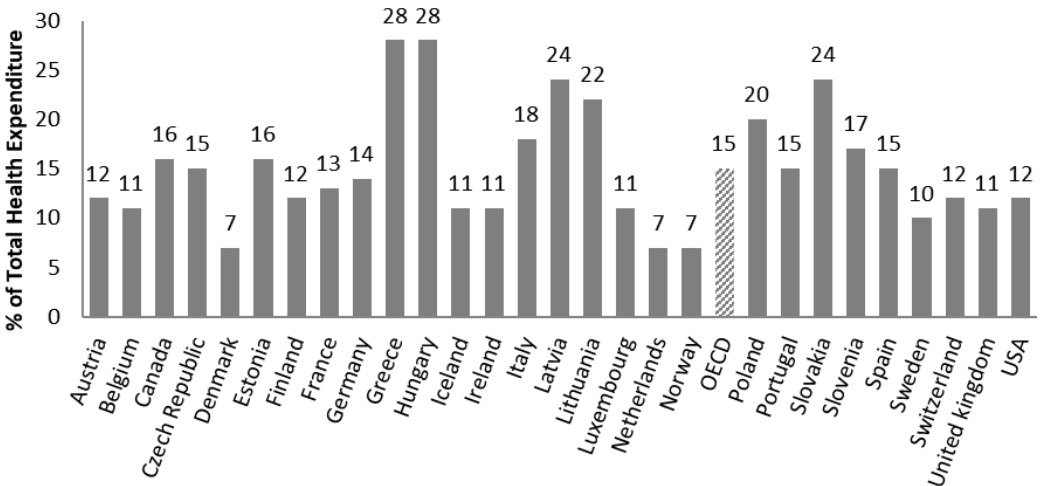
Figure 2. Pharmaceutical Spending as % of total Health Expenditure in 2019 (pharmaceuticals in hospitals are not considered) [2]. hospitals are not considered)